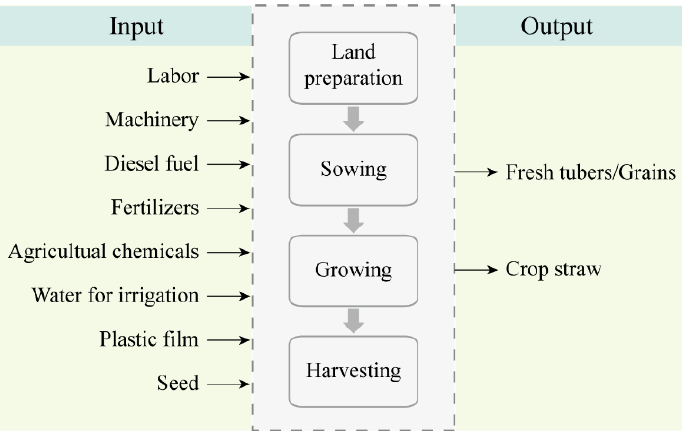
Figure 2. System boundary of sweet potato and reference crops (i.e., rice, maize, and potato) pro- duction.